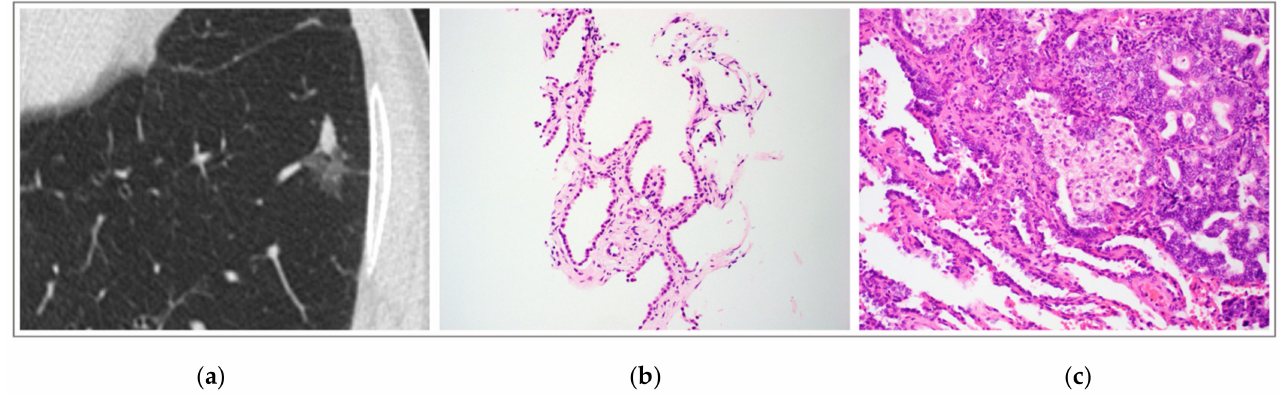
Figure 2. ( a ) Computed tomography of chest with part solid nodule in left lower lobe. Solid component of nodule had demonstrated interval growth. ( b ) Lung biopsy showing intact alveolar septa lined by atypical pneumocytes with hobnail appearance, hyperchromatic nuclei and scant cytoplasm. There is no interstitial, pleural or lymphatic invasion present (H&E, 200 × magnification). ( c ) Lung resection showing areas of non-invasive lepidic growth (bottom left), immediately adjacent to areas of interstitial invasion (top right) (H&E, 200 ×